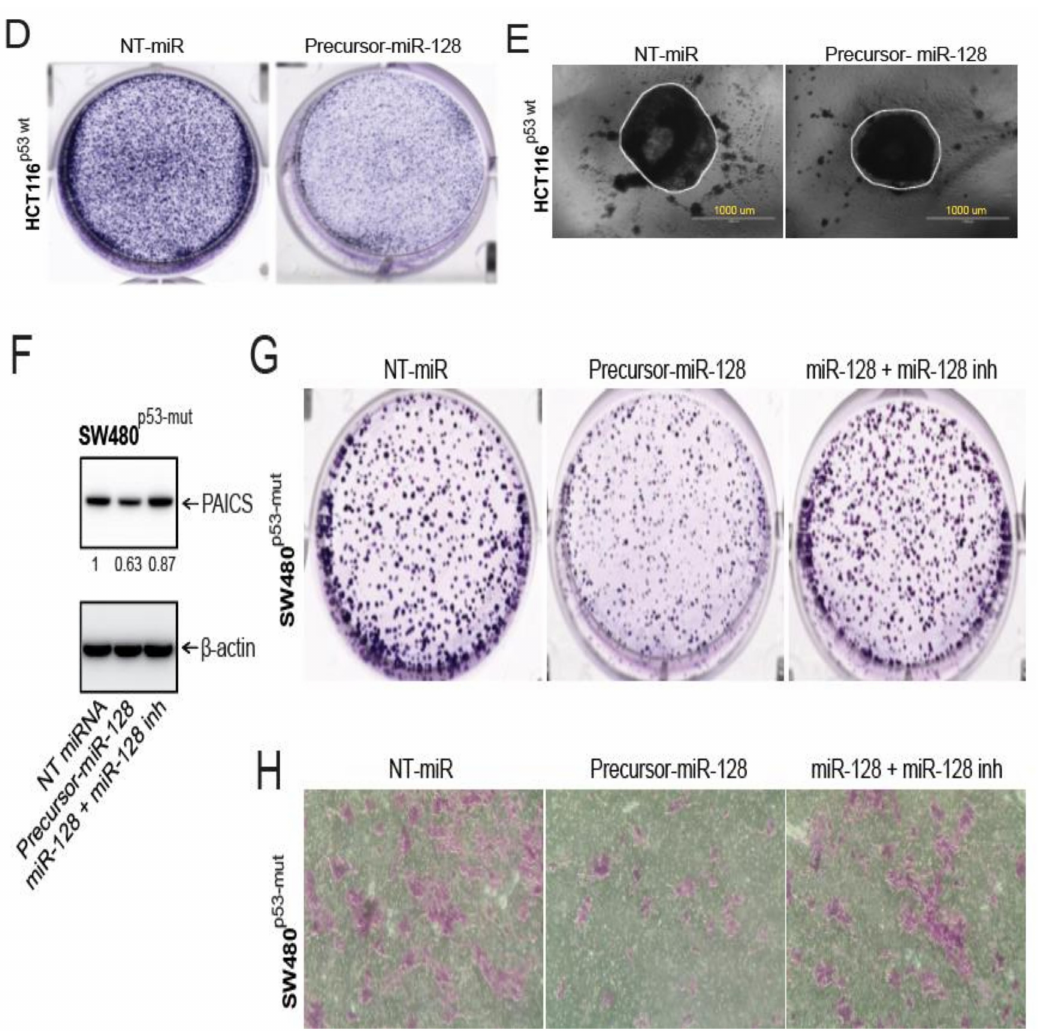
Figure 7. PAICS in CRC is regulated and targeted by miR-128. ( A ) HCT116 p53-wt was transfected with NT-pre-miR, miR-128, miR-141, or miR-146 followed by the immunoblot analysis of PAICS protein expression. The numerical values below the blots indicate the normalized ratio of the PAICS / β -Actin. ( B ) The precursor miR-128 or NT pre-miR was co-transfected with luciferase constructs of either PAICS-3’UTR wild-type or mutant. The transfection of HCT116 p53-wt cells was accomplished with either NT-pre-miR or miR-128 to assess ( C ) cell proliferation, ( D ) colony formation, and ( E ) spheroid formation; scale bar—1000 µ m. ( F ) An immunoblot analysis to show the restoration of the PAICS levels after the ectopic expression of miR-128 followed by co-transfection of precursor-miR-128 and inhibitor of miR-128 in SW480 p53-mut cells. Transfections were performed to assess the ( G ) colony formation and ( H ) cell invasion